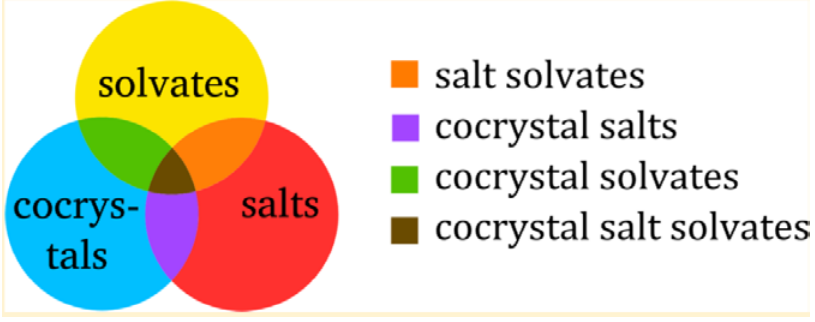
Figure 3. Schematic representation of proposed multicomponent classification system by Grothe et al. [46] [Reprinted from [46] with permission. Copyright 2016 American Chemical Society].